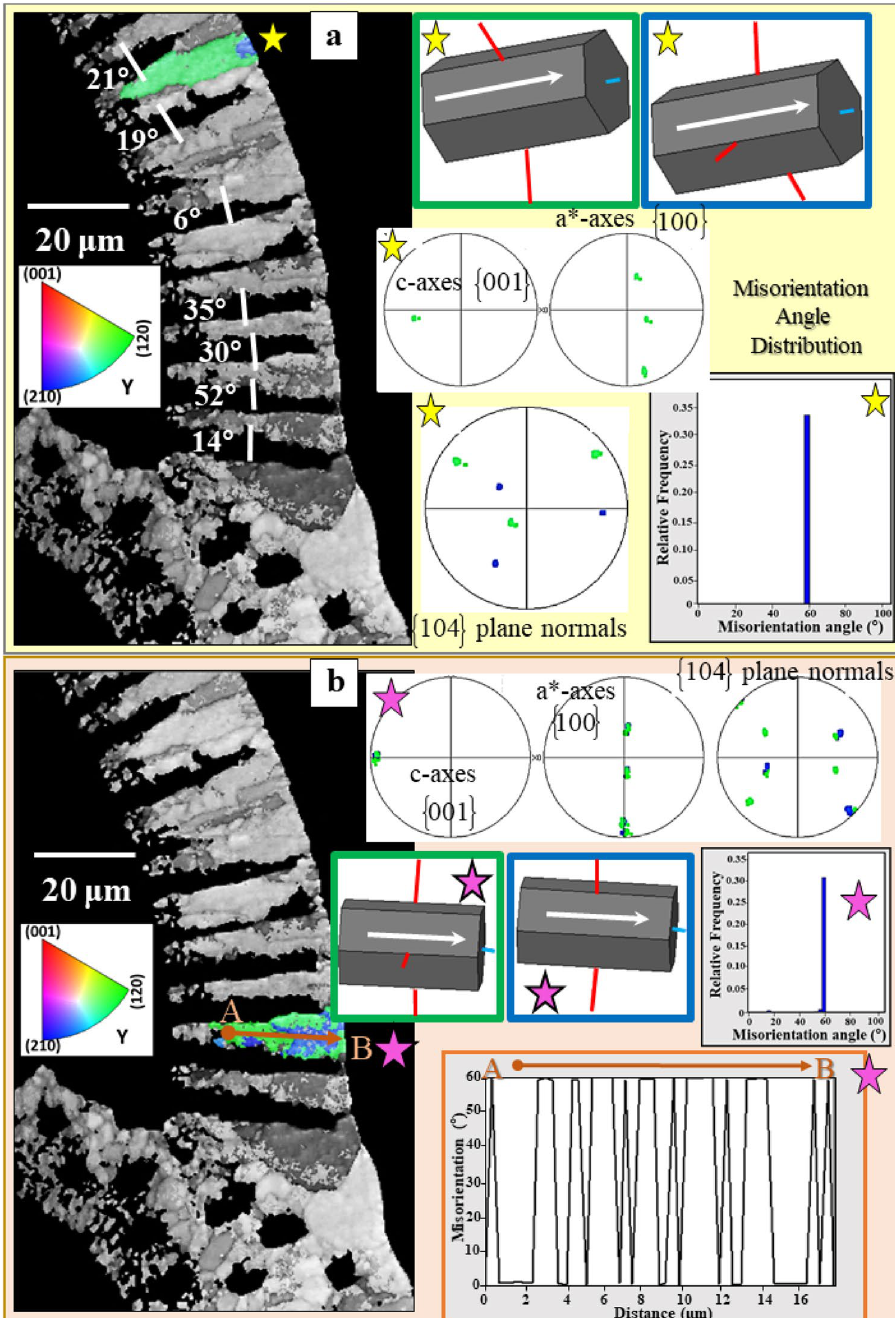
Figure 7. The different misorientations between calcite within and between adjacent cone-shaped units in Pulleniatina obliquiloculata shells. ( a ) and ( b ) EBSD band contrast measurement (given in grey) of a cross- section through the shell wall with, for a selected cone-shaped unit (yellow and magenta stars in ( a ) and ( b )), mode of twin individual/domain orientation (sketched crystals), corresponding pole figures, misorientation angle distribution and misorientation-distance diagrams. The pole figures and latter diagrams demonstrate that the calcite of the cone-shaped units is twinned. Neighboring cone-shaped units are only misoriented to each other ( a ). Calcite c-axes are always perpendicular to the shell wall (white arrows in and orientation of the sketched crystals) and rotates with the curvature of the shell; see the slight change in calcite c-axis orientation of the sketched